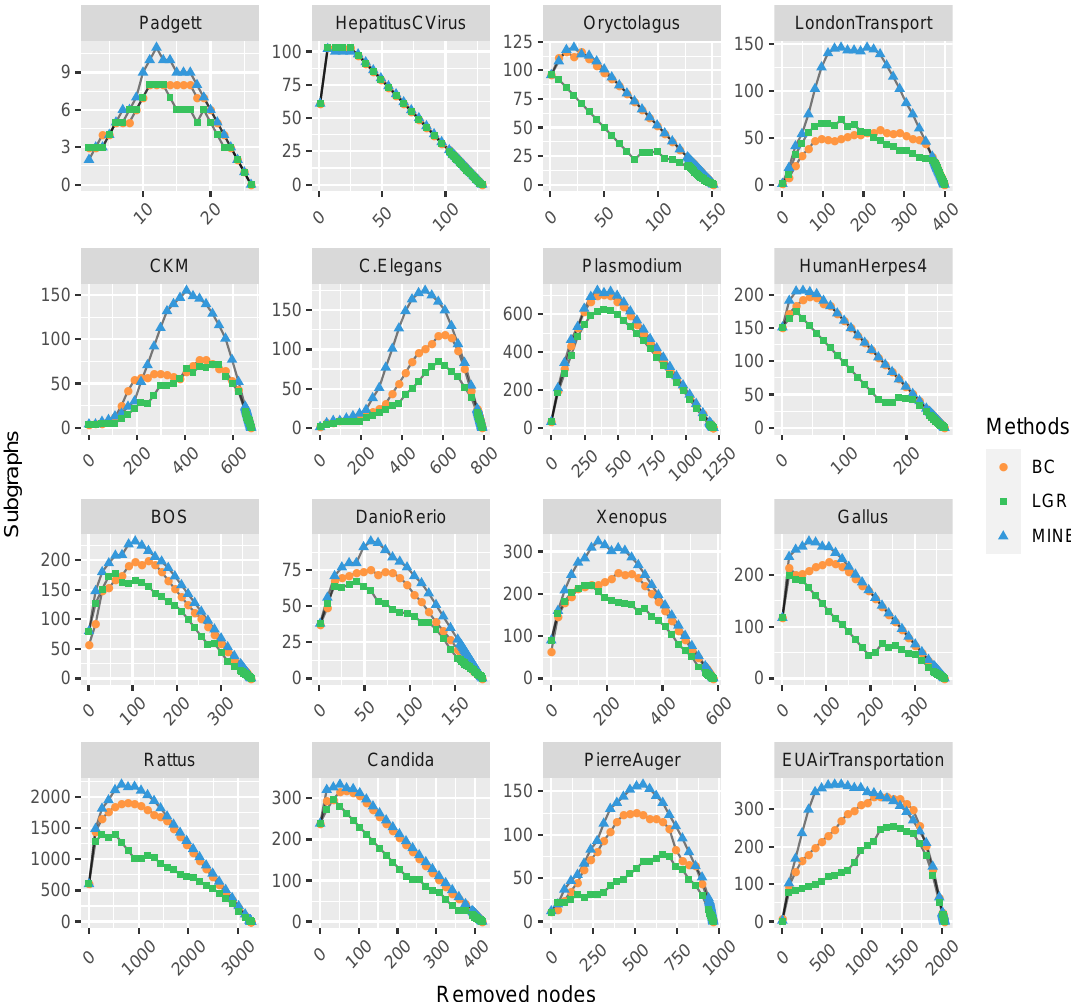
Figure 3. The comparison of varying subgraphs with the removal of the most influential nodes repeatedly with each centrality method on 16 multilayer networks. The proposed MINE algorithm (marked with blue triangles) shows superiority to the BC and LGR methods on the majority of datasets except for HepatitusCVirus, while it is close to the performance of the LGR method (marked with green